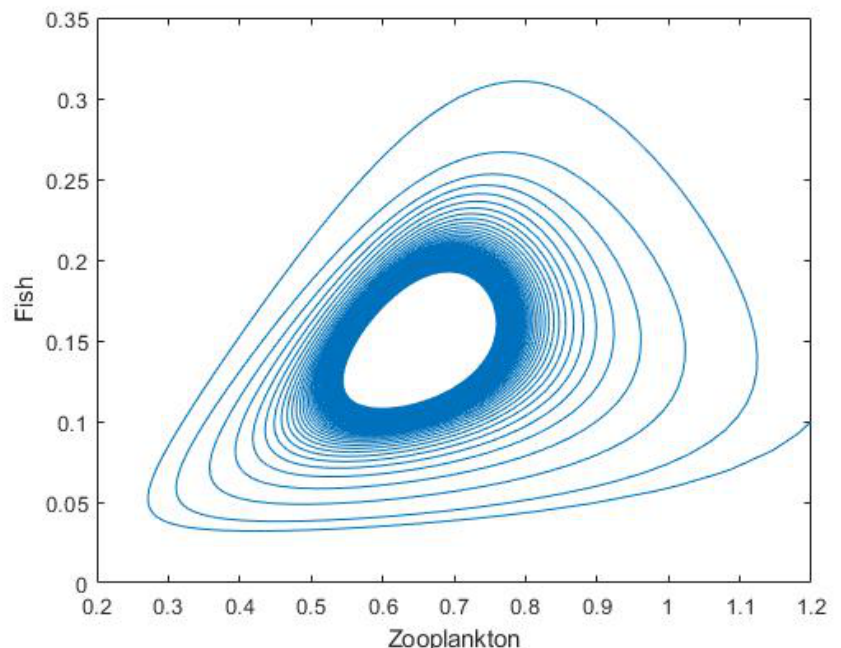
Figure 19. Equilibrium between the zooplankton and fish populations loses its stability for τ = τ +